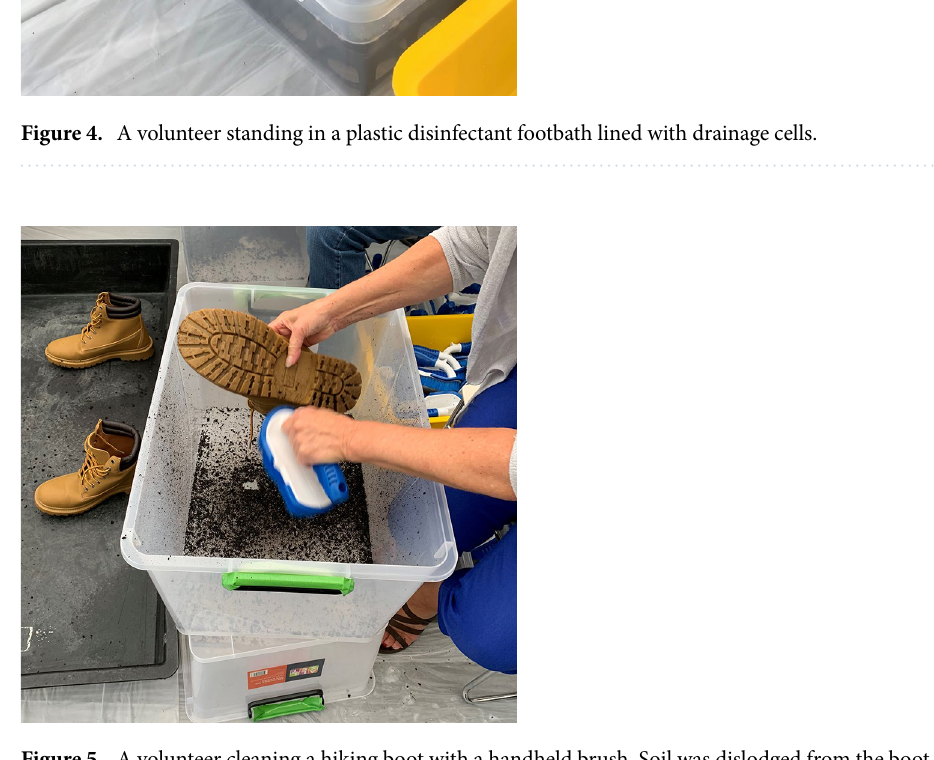
Figure 5. A volunteer cleaning a hiking boot with a handheld brush. Soil was dislodged from the boot and collected in a clean plastic tub and the cleaned boot was then placed in a bucket for subsequent pathogen